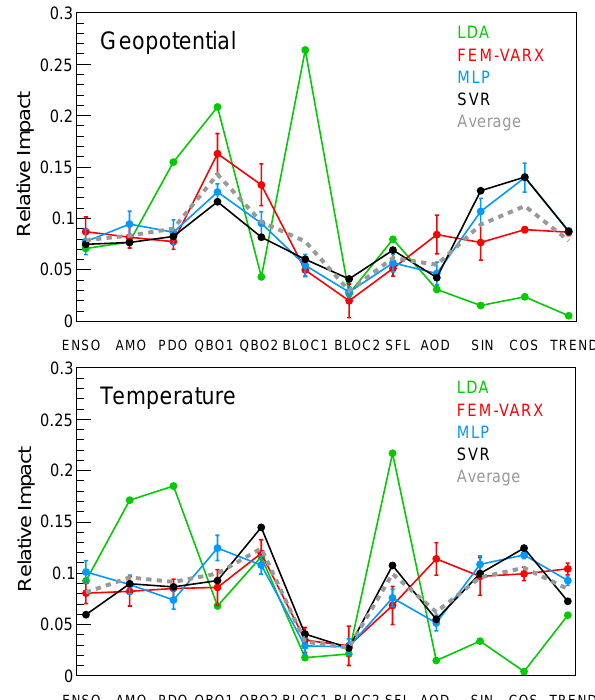
Fig. 3. Relative impact of the external factors on each of the statis- tical models for geopotential (top) and temperature (bottom). The average impact (gray) is calculated as a weighted mean over the different models where the weights are calculated from the correla- tion coefficients (see left panel of Fig. 2) on the training period. The error bars of the FEM-VARX and MLP impacts denote the 95% confidence interval calculated from the 30 model